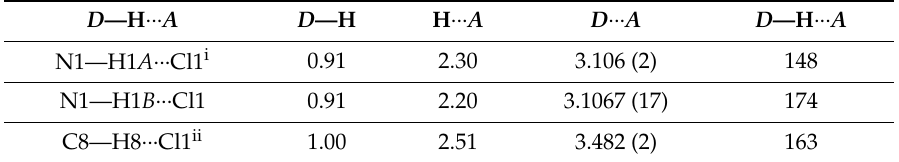
Figure 9. The molecular structure of 2-(ethylamino)-1-(3-methylphenyl)propan-1-one hydrochloride ( 4 ), showing the atom-labelling scheme. Table 5. Hydrogen-bond geometry (Å, ◦ ) for Compound 4 .